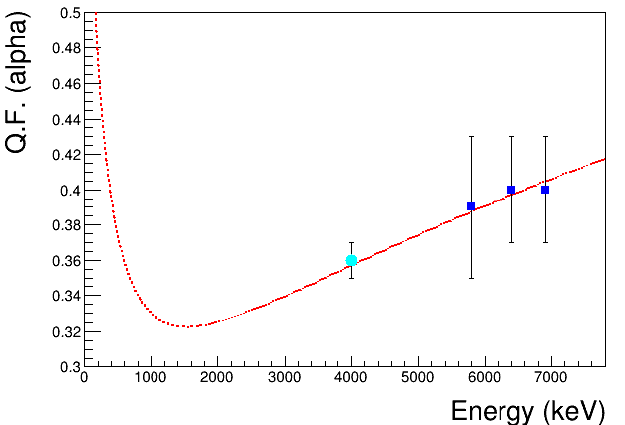
Figure 3. Dependence of the quenching factor (QF) on the energy of alpha particles measured by internal alpha decays of 224 Ra, 220 Rn, 216 Po nuclides in the 7 g CHC crystal (blue squares) [7]. The QF model obtained as a global fit of these data points following the phenomenological model of [37] is also presented (red dotted line). The QF measured with external collimated 241 Am alpha source from [15] is also shown (cyan circle).